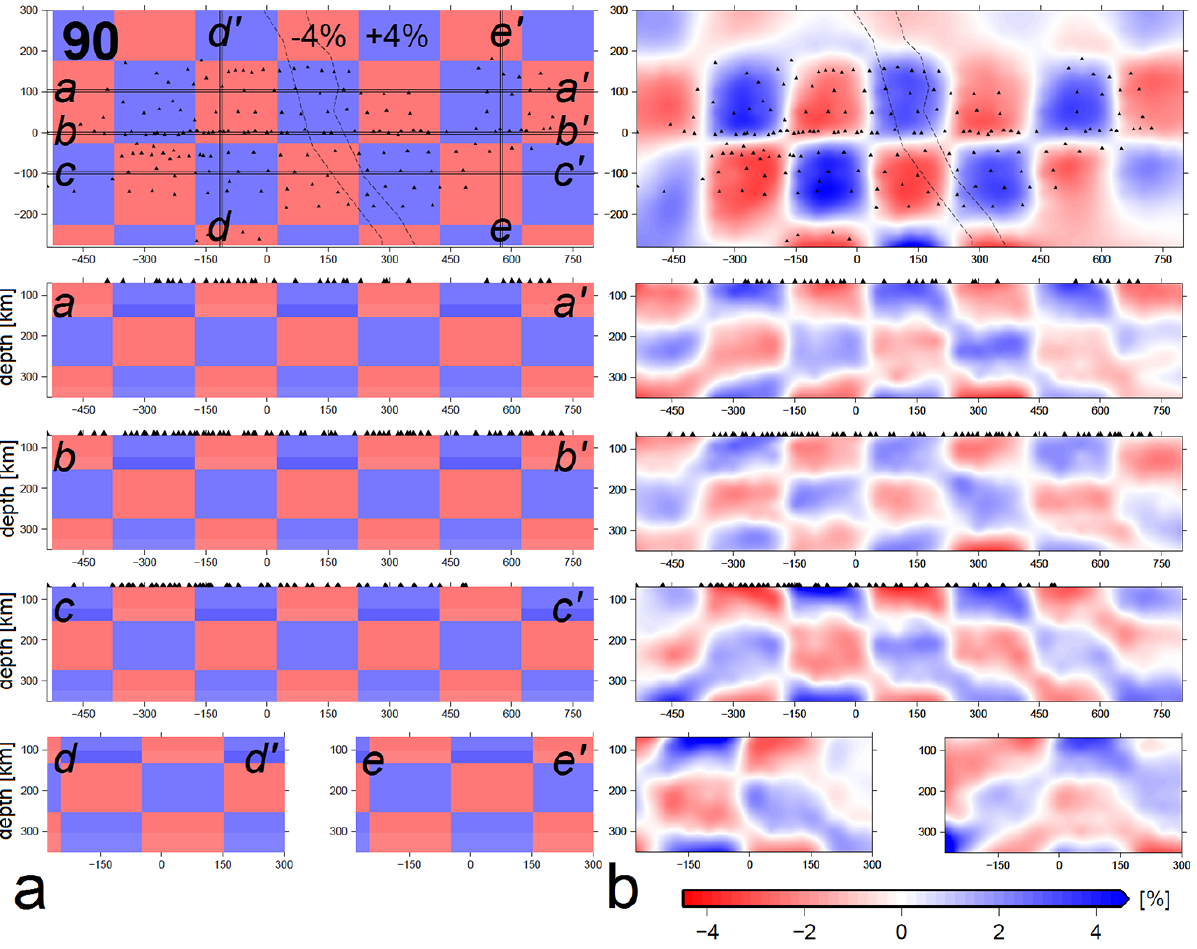
Figure 7. Checkerboard test. Horizontal slice at a depth of 90km and vertical slices along the depicted transects. (a) Initial velocity model. (b) Inversion results with the synthetic data set. Triangles mark the seismic stations. Dashed lines indicate the position of the